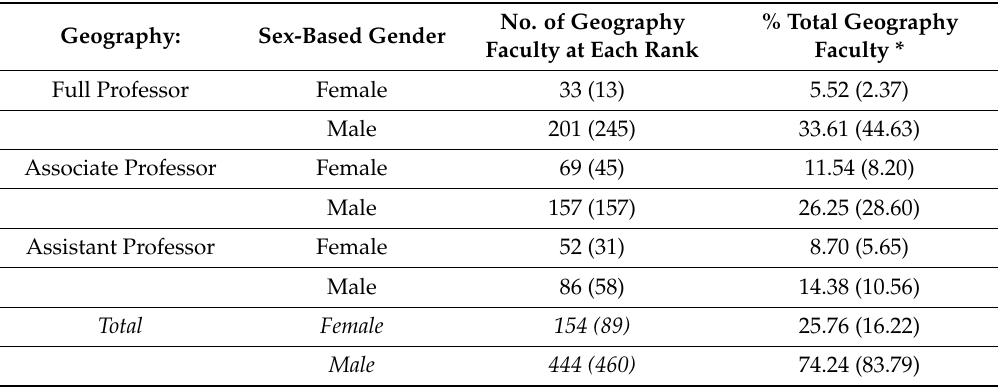
Table 3. Gender-based representation of faculty in geography departments at Canadian universities.